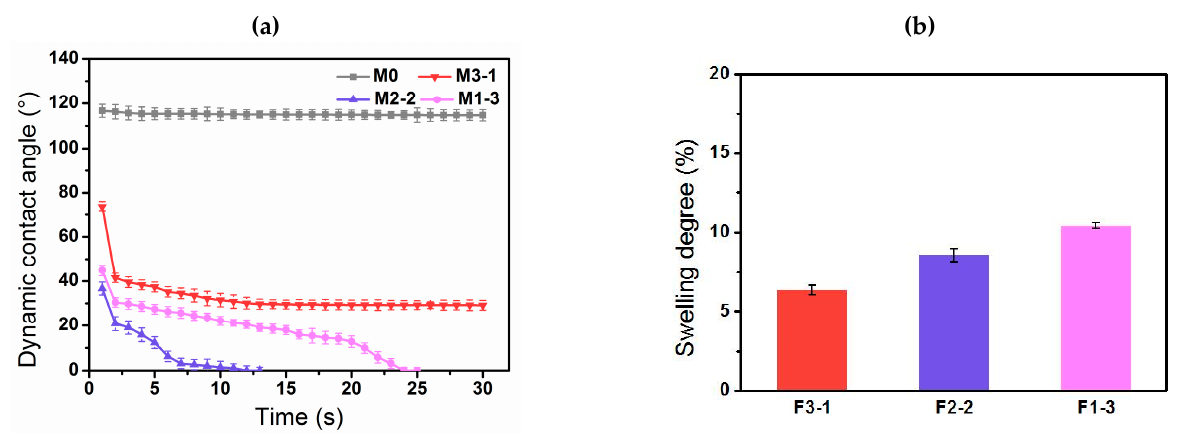
Figure 7. ( a ) Time-dependent water contact angle of membrane surfaces and ( b ) swelling degree of hydrogel layers on films (without pores).